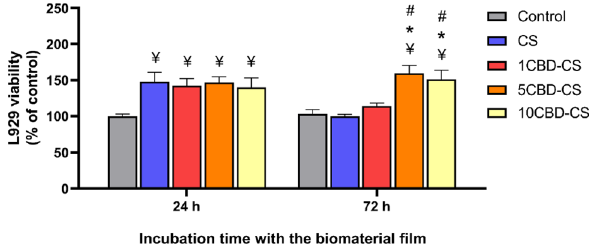
Figure 8. Cytotoxicity evaluation in L929 fibroblast cell culture. The viability of L929 cultured with the prepared films for 24 and 72 h (direct test). The results are presented as the percentage of the cell